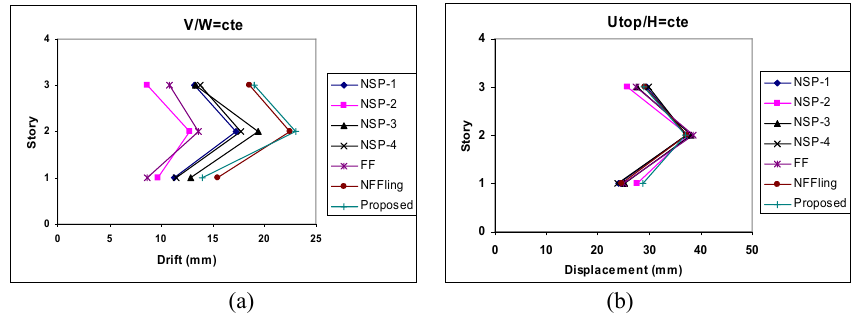
Figure 11. Interstorey drift for 3-storey building with (a) V/W=cte, (b) U top /H=cte